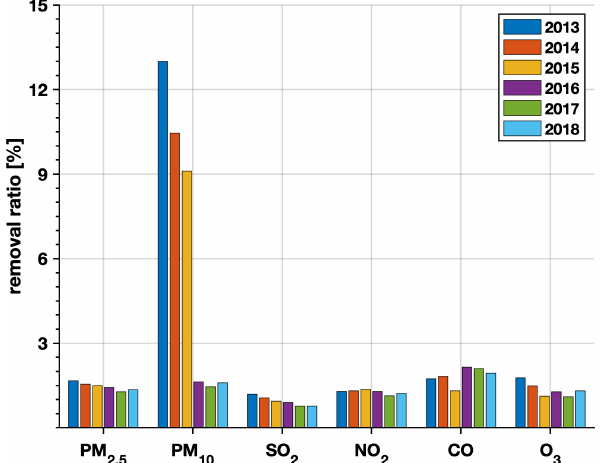
Figure A1. Removal ratio of the observations in China from 2013 to 2018 for different species detected by the automatic outlier detection method.